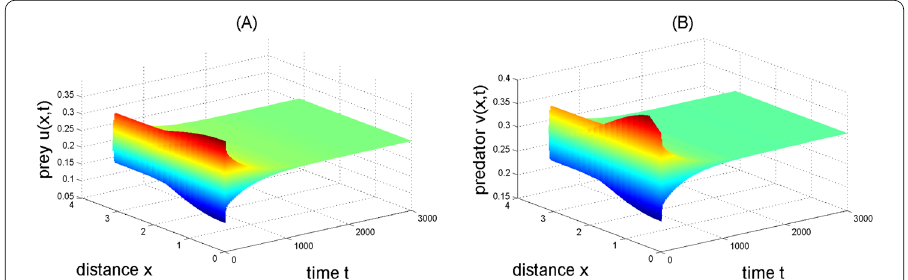
Figure 1 The positive equilibrium ( u ∗ , v ∗ ) of system (1.1) is asymptotically stable in the situation when the value of the parameter c = 0.8 > 0.7366. Here we choose to set the parameter values d 1 = 0.05, d 2 = 0.1, γ = 1, β = 0.5048, and for the initial values we take u ( x ,0) = 0.3042 + 0.05cos x , v ( x ,0) = 0.3619 + 0.05cos x